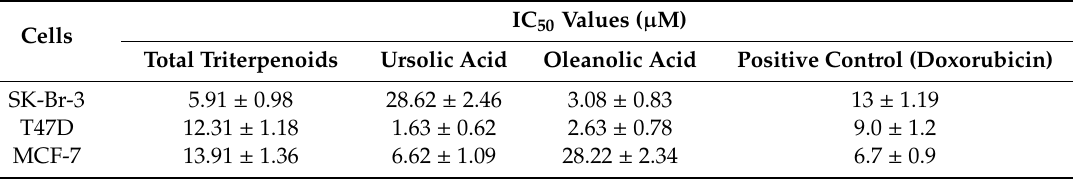
Table 2. The IC 50 values ( µ M) of total triterpenoids after purification, ursolic and oleanolic acids from the D. heterophyllum against SK-Br-3, T47D, and MCF-7